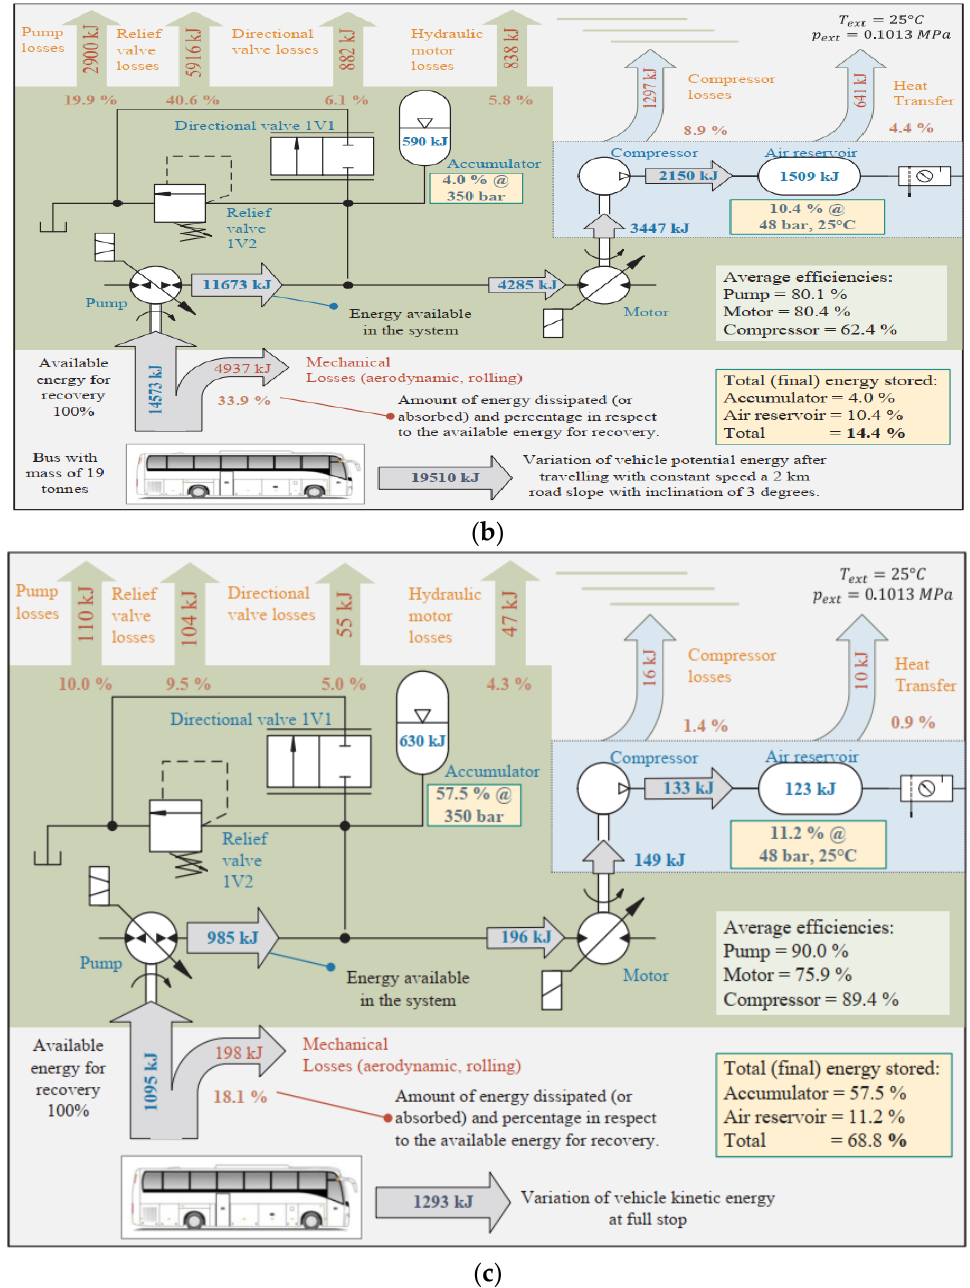
Figure 14. Parallel hydraulic–pneumatic recovery braking system [95]: ( a ) diagram of the configuration used; ( b ) total energy flow at 40 km/h on a 2 km downhill slope with 3°; ( c ) total energy flow after braking to full stop.